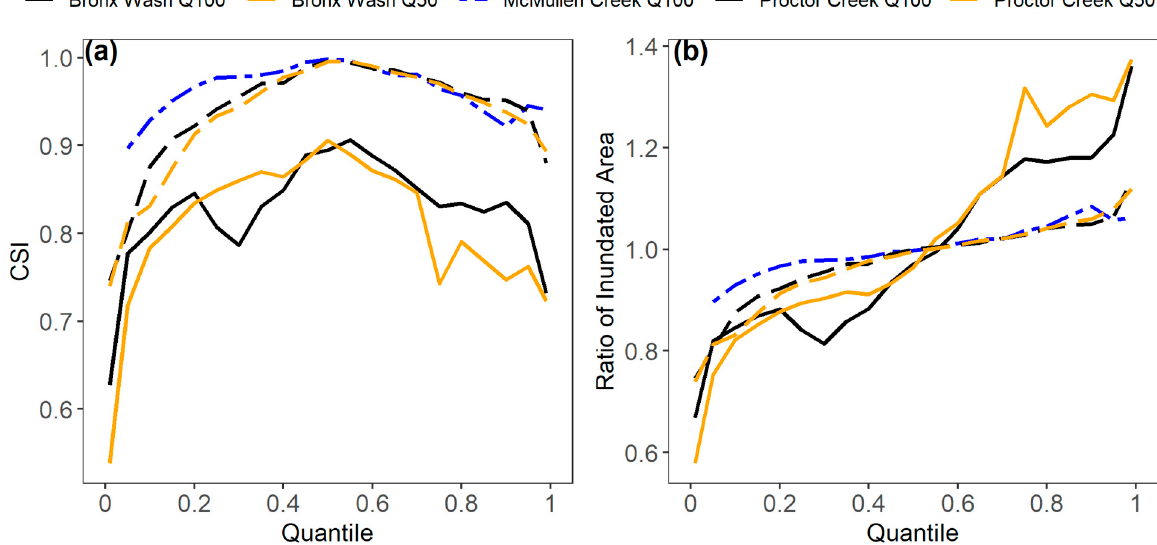
Figure 4. ( a ) Critical success index comparing SUB against MCS for each reach and flood frequency and ( b ) the ratio of inundated area estimated by SUB relative to MCS. McMullen Creek from Stephens and Bledsoe